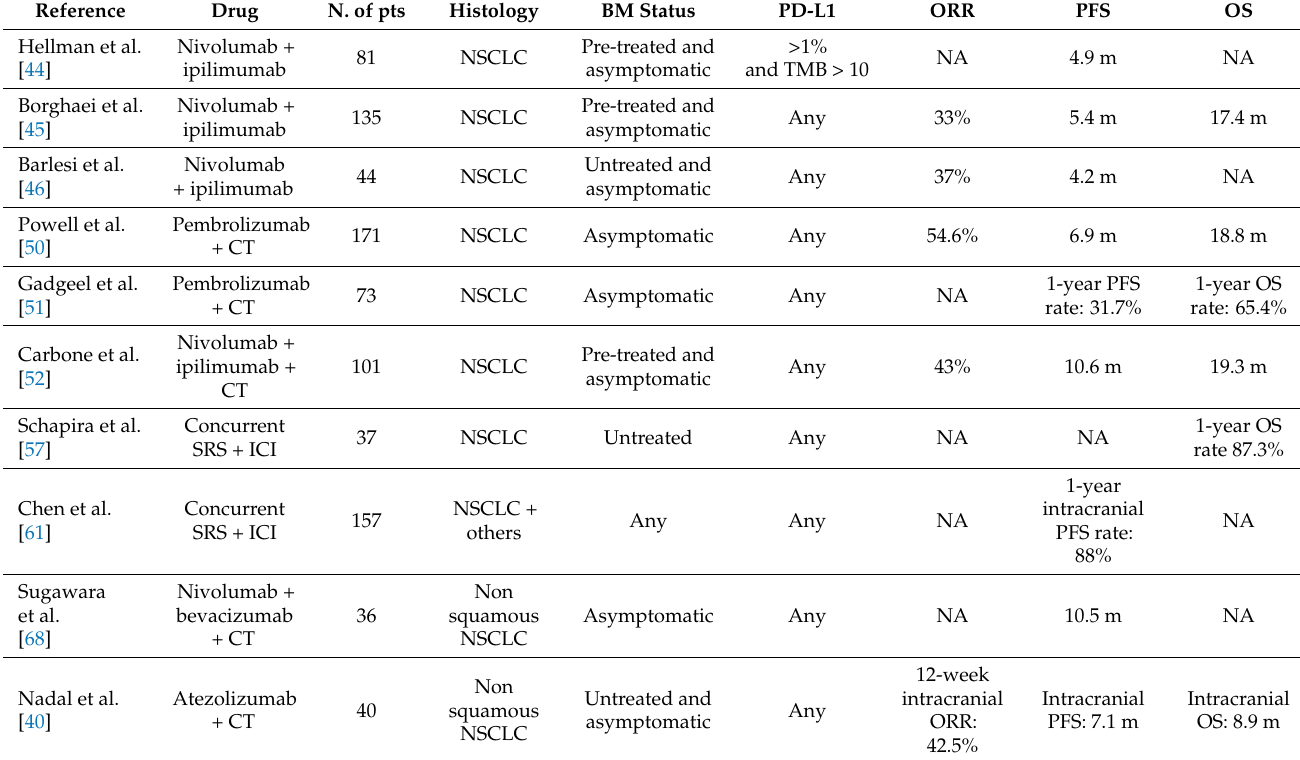
Table 2. Outcomes of patients with NSCLC and BMs treated with combination